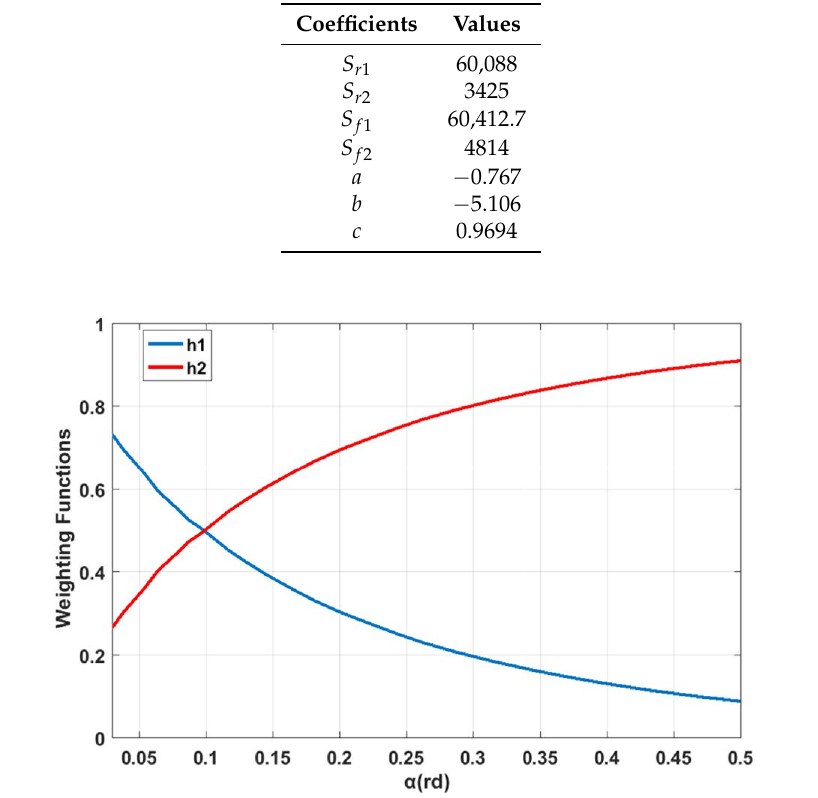
Figure 2. h 1 and h 2 representative